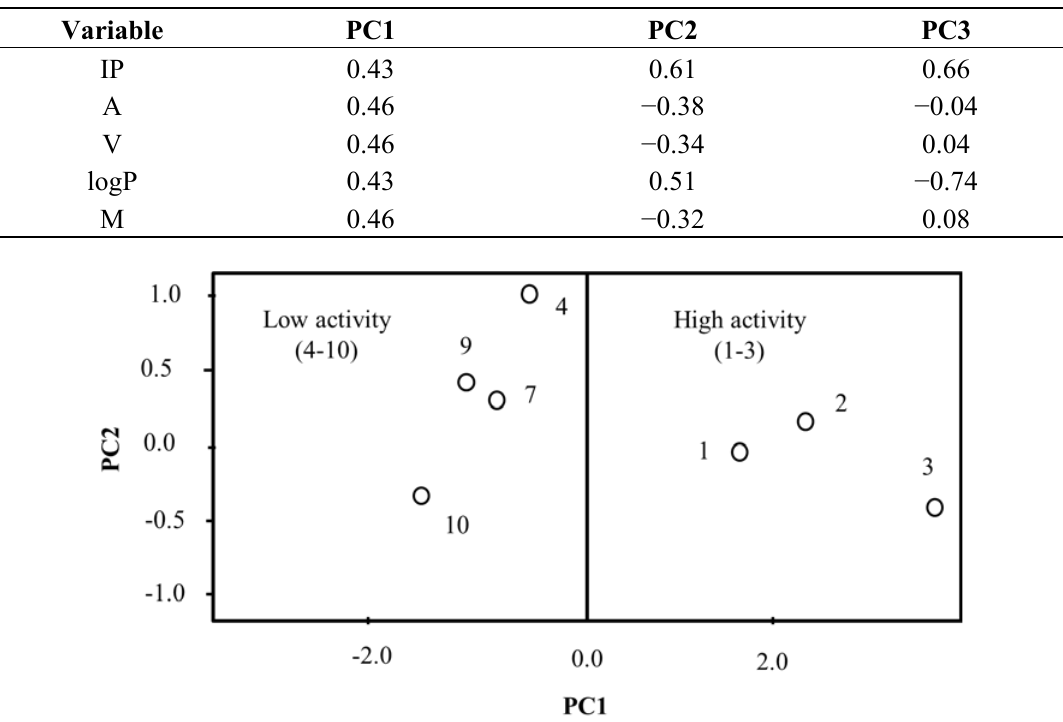
Table 5. Loading vectors for the first three principal components.